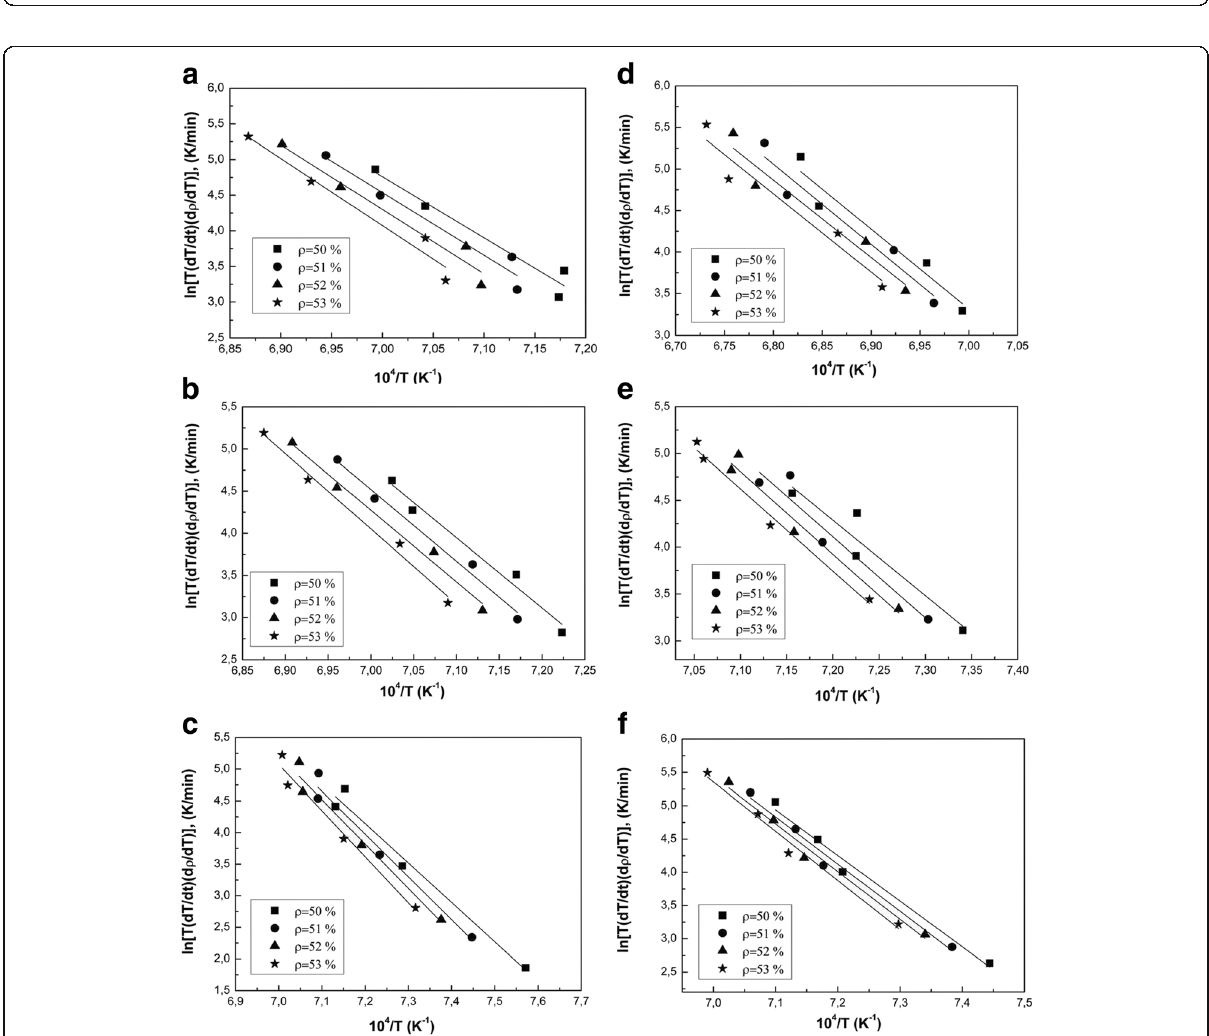
Fig. 8 Arrhenius-type plots of ( a ) 3Y-TZP, b PM4-3Y-TZP, c PM8-3Y-TZP, d 3Y-TZP-0.2 wt% SiO 2 , e PMM4-3Y-TZP-0.2 wt% SiO 2 , and f PMM8-3Y- TZP-0.2 wt% SiO 2 nanopowders